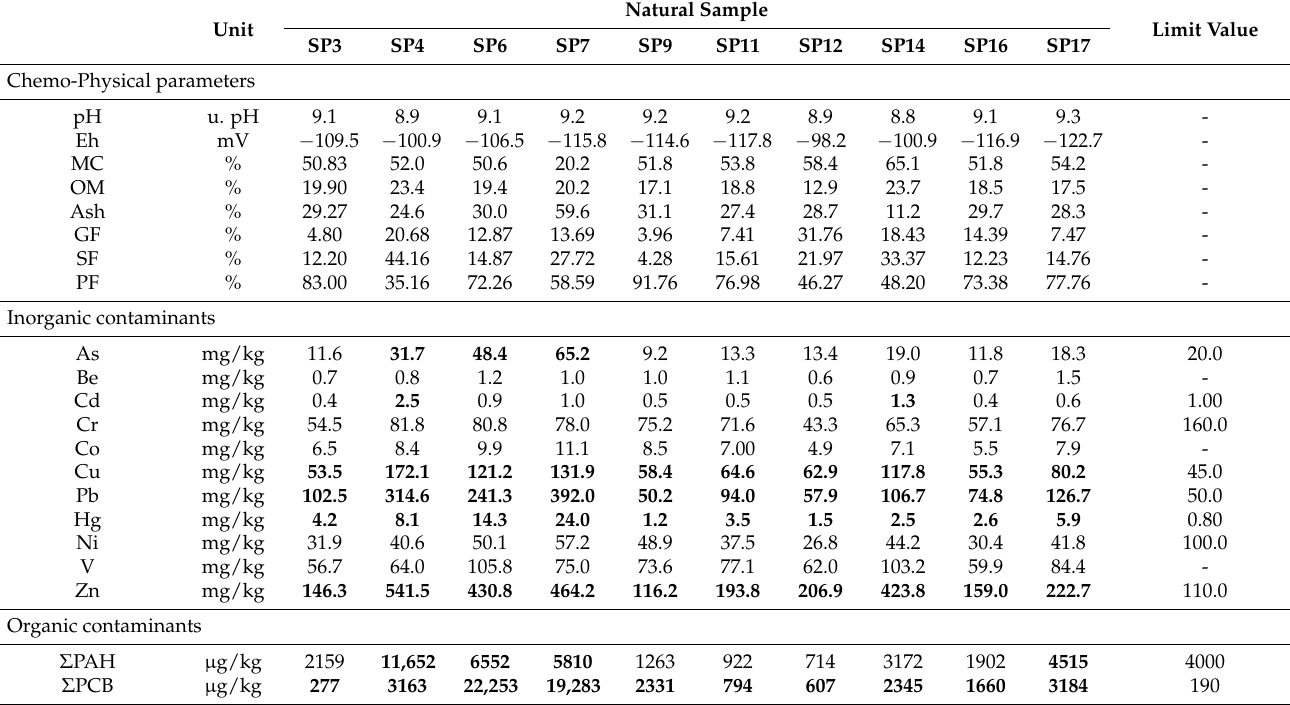
Table 2. Chemo-physical and particle-size characterizations of natural sediment